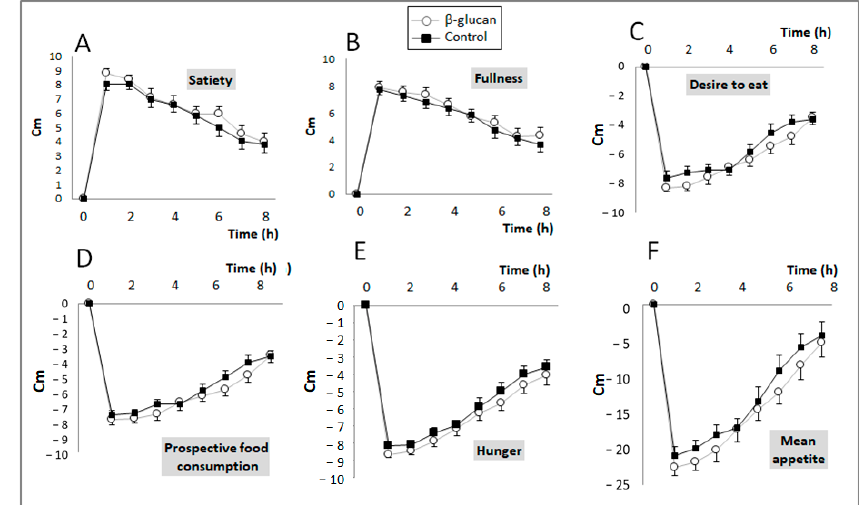
Figure 2. Changes in subjective feelings (VAS score) of satiety/appetite during the postprandial period after eating breakfast with foods enriched (Grey line) or not (black line) with β -glucan. A —Satiety (Treatment (Trt.) × Time: p = 0.65); B —Fullness (Trt. × Time: p = 0.95); C —Desire to eat (Trt. × Time: p = 0.29); D —Prospective food consumption (Trt. × Time: p = 0.39); E —Hunger (Trt. × Time: p = 0.97); F —Mean appetite score (Trt. × Time: p = 0.83). Means ± SEM. Two-way ANOVA for repeated measurements (Treatment × time interaction). However, when the results were expressed as AUCs for each of these variables (Ta- ble 2), paired comparisons indicate that breakfast with β -glucan-enriched foods non-significantly decreased “desire to eat” ( p = 0.05) and significantly decreased hunger and prospective food consumption ( p = 0.04 and p = 0.033, respectively). Accordingly, the subjects’ mean appetite score also significantly decreased in the β -glucan period ( p = 0.014). Table 2. Area under the VAS curves (AUC) for satiety, fullness, hunger, food craving, prospective food consumption, and calculated values for mean appetite score during the control and β -glucan periods. Means ± SD.